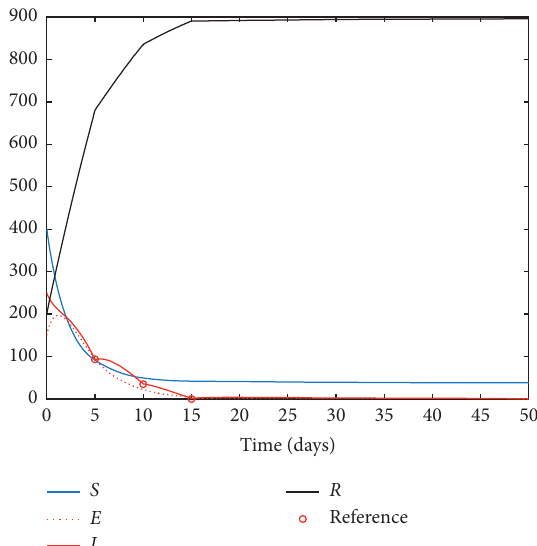
Figure 9: Evolution of the closed-loop system for the output targeting procedure.